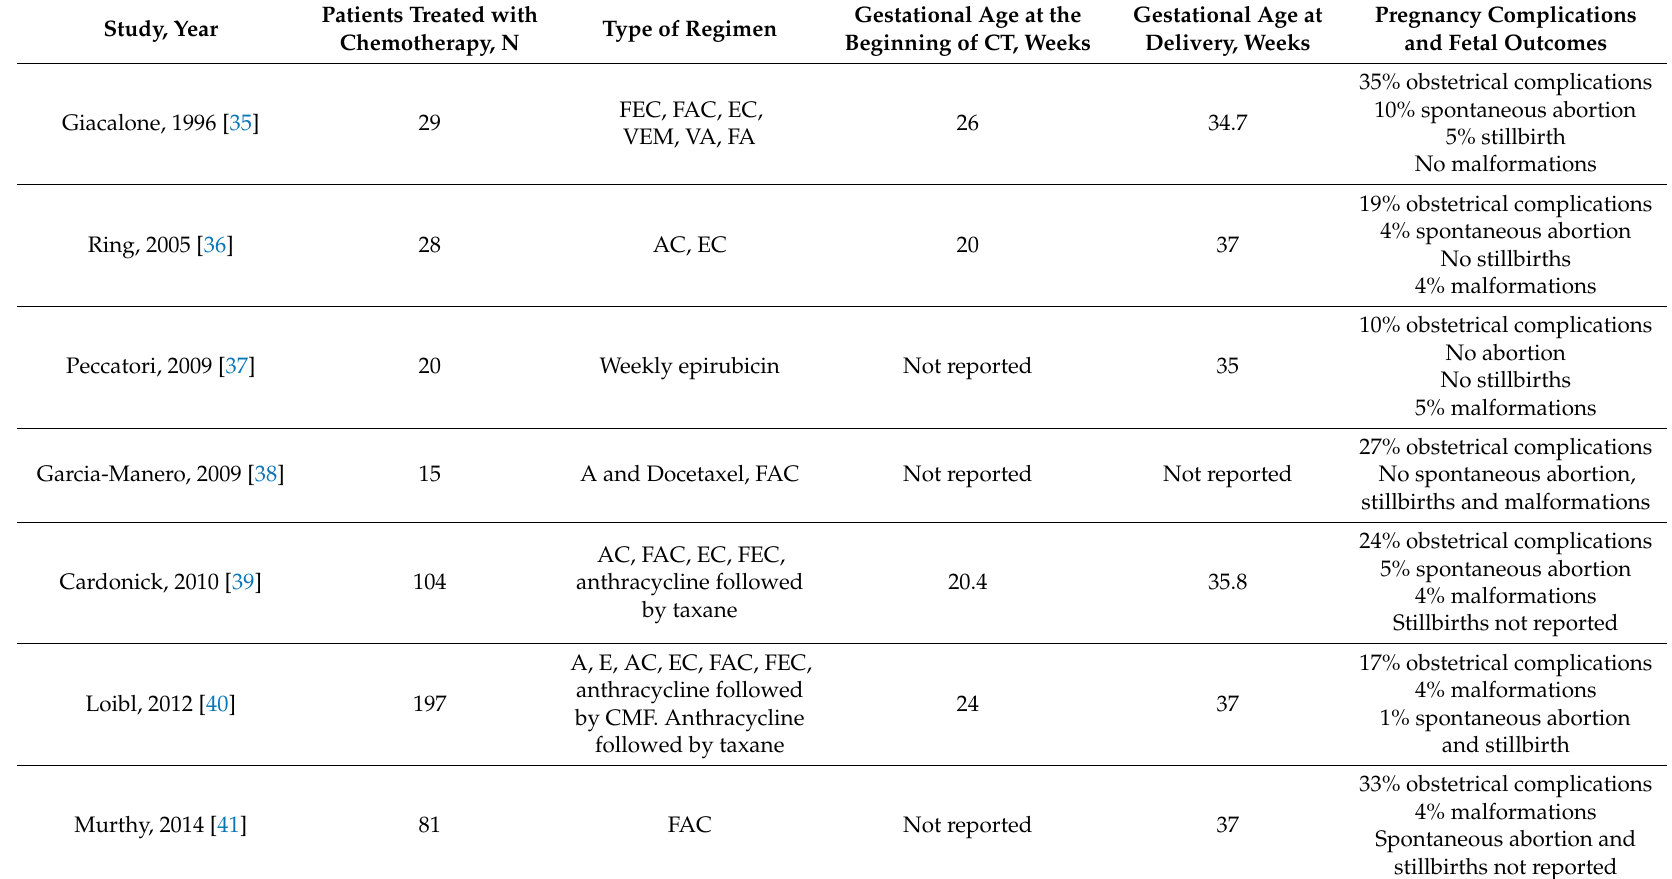
Table 1. Main results of the studies assessing the use of anthracyclines and taxanes-based regimens in patients with breast cancer during pregnancy (with at least 10 patients